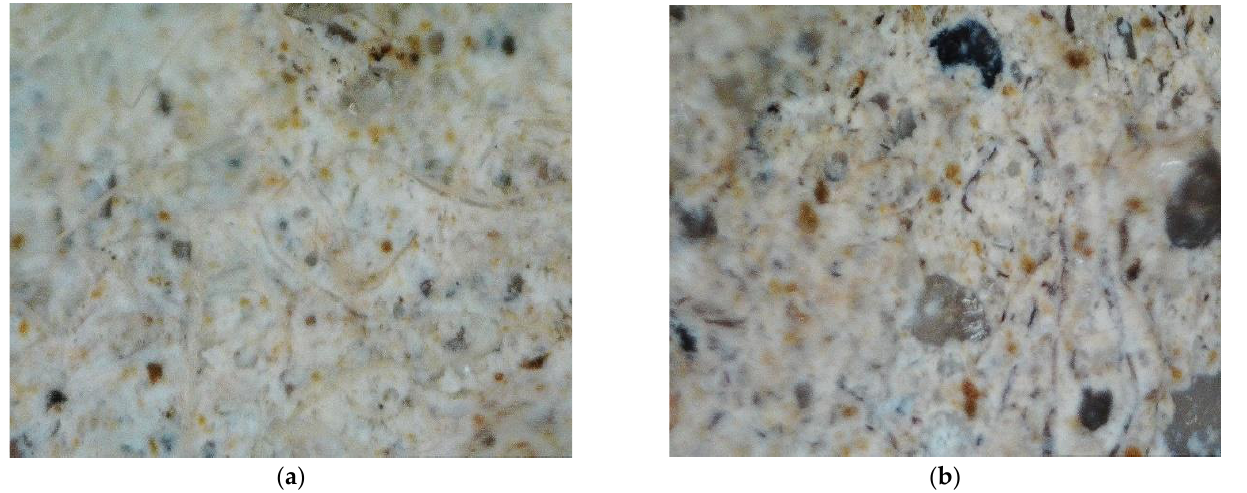
Figure 6. Sample E macrostructure zoomed in 12 times: ( a ) before fire effect; ( b ) after fire effect.